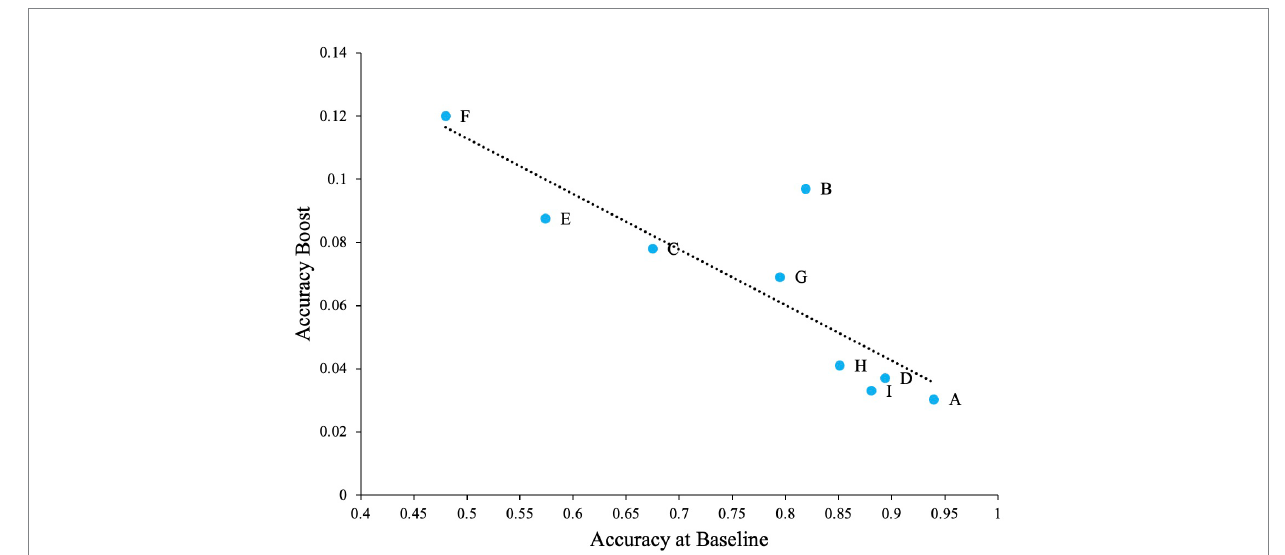
FIGURE 11 The impact of letters in the SR task when the task contains salient letters (online experiment). Dashed line indicates the regression line (trendline). Plot shows negative association between baseline accuracy and improvement in accuracy above baseline (accuracy boost). The baseline is accuracy of participants at zero external noise